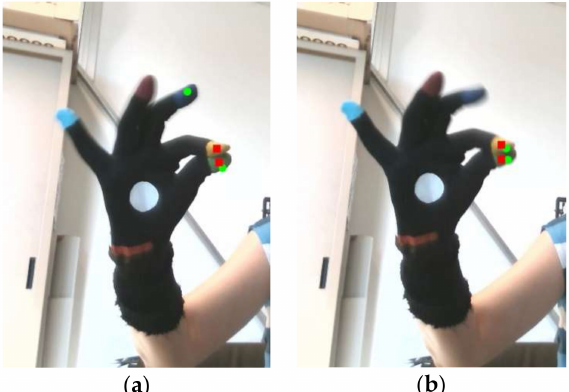
Figure 10. 2D re-projections on RGB images of the 3D fingertip positions. Thumb and index from Intel RealSense ® tracker (green filled circles) versus thumb and index positions as estimated by the HCI tracker (red filled rectangles): ( a ) Incorrectly evaluated position of index finger by the Intel RealSense ® tracker (joint on middle finger, P1 in Figure 9); ( b ) Correctly evaluated position of the index finger for Intel RealSense ® tracker (P3 in Figure 9).